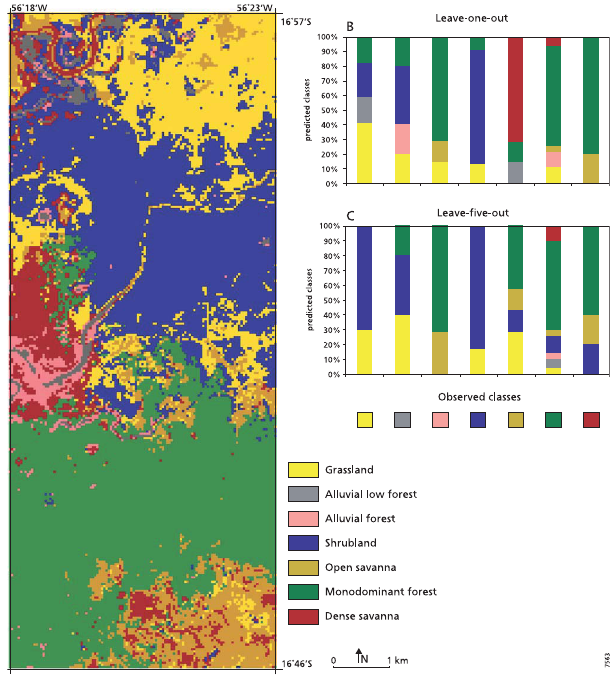
Fig. 7. (A) Predicted distribution of the plant communities iden- tified at the study site. (B) Results of leave-one-sample out cross- validation. Percentage of predicted classes at sampling locations. Each bar shows the results for sampling locations with a certain ob- served class (indicated by the colors at the bottom of the C panel). (C) Idem, leave-five-out cross-validation. N =